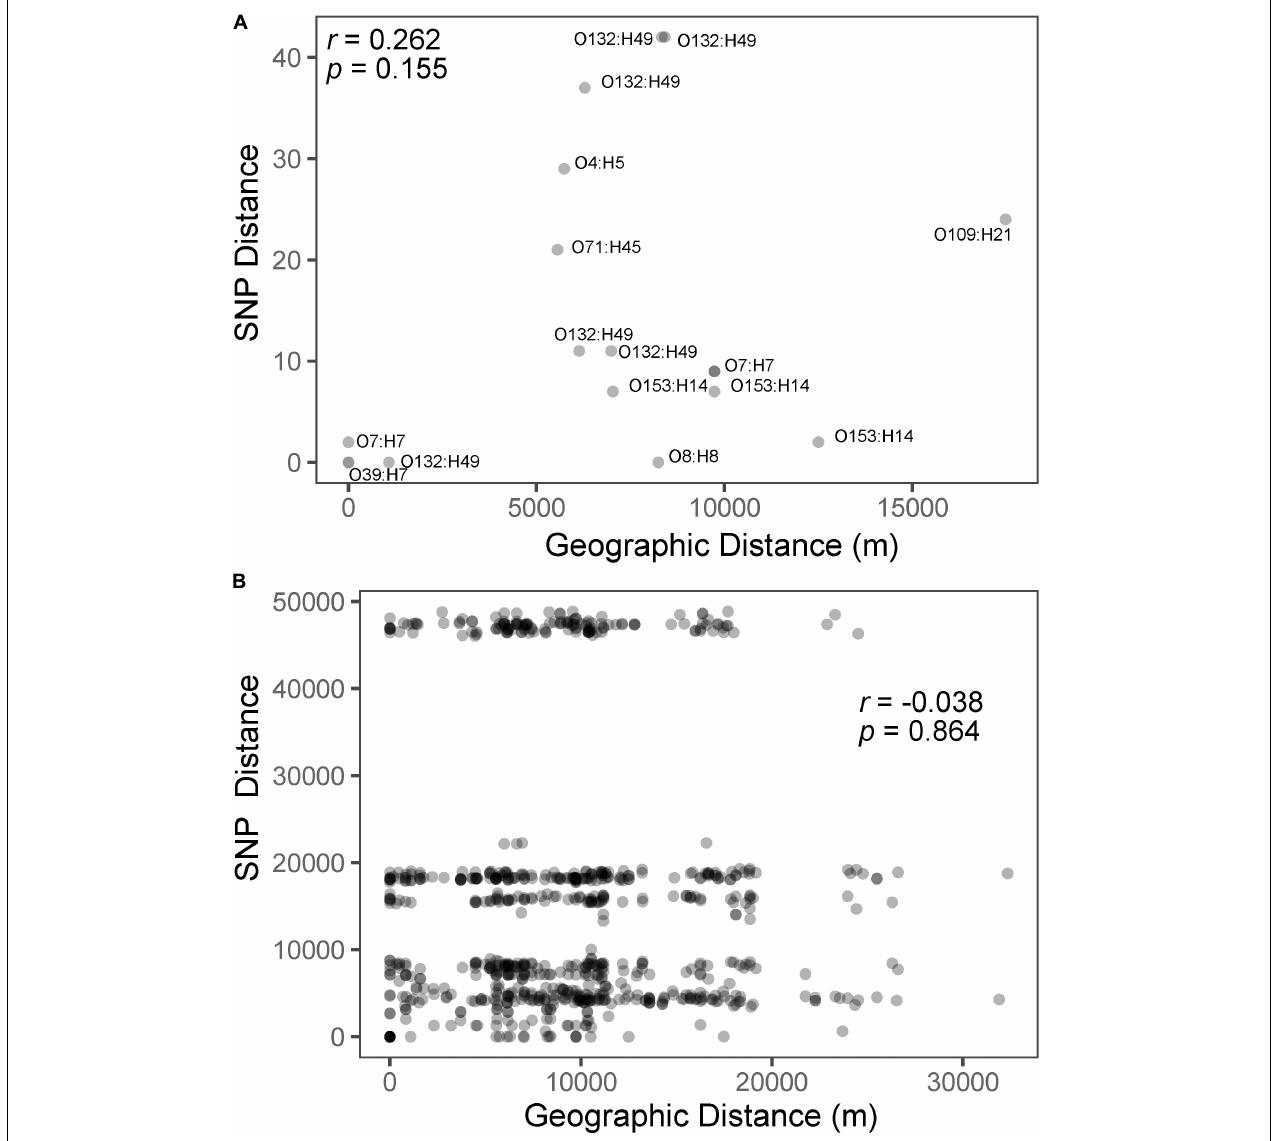
FIGURE 3 | Isolation by distance plots and correlation coefficients for only those from the same serotype with points labeled according to serotype (A) and for all isolates (B) . The three horizontal groups of points are the result of pairwise comparisons between isolates from each of the three major phylogenetic clades ( Figure 2